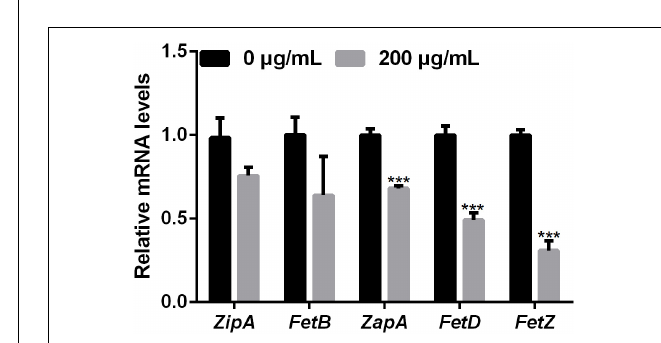
FIGURE 2 | Statistical analysis of the swimming motility (A) and biofilm formation of Xoo (B) treated with melatonin. ∗ P < 0.05, ∗∗∗ P < 0.001.